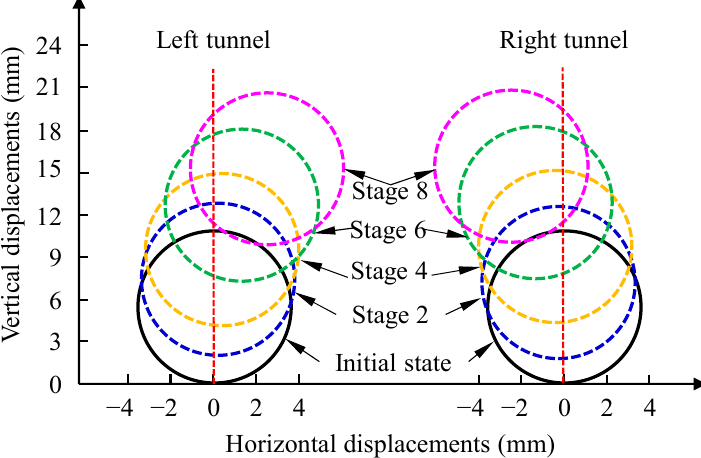
Figure 8. Tunnel deformation responses for different excavation stages.